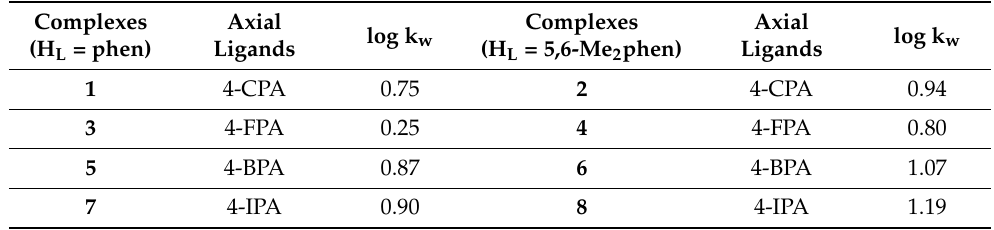
Table 5. A summary of log k w values of 1 – 8